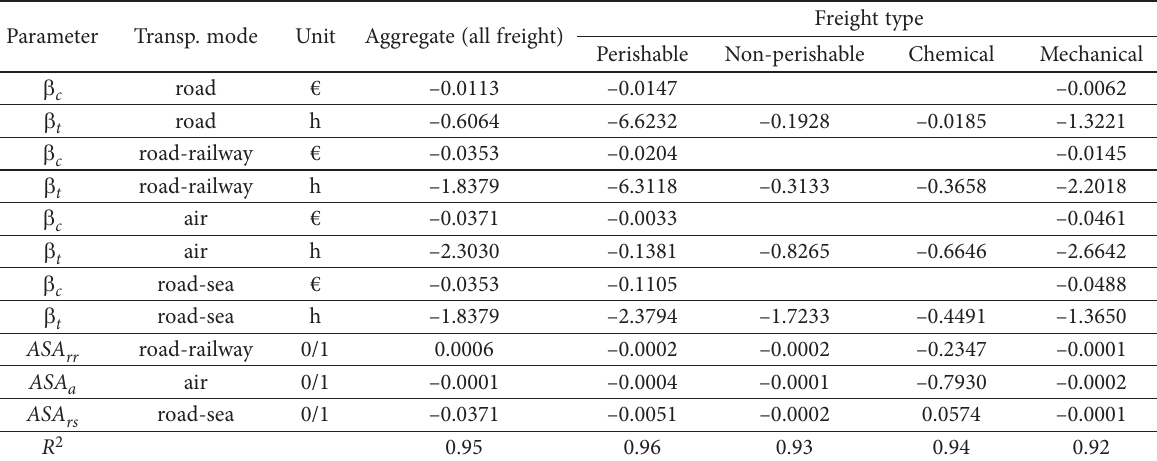
Table 9. Mode choice model for import calibration results